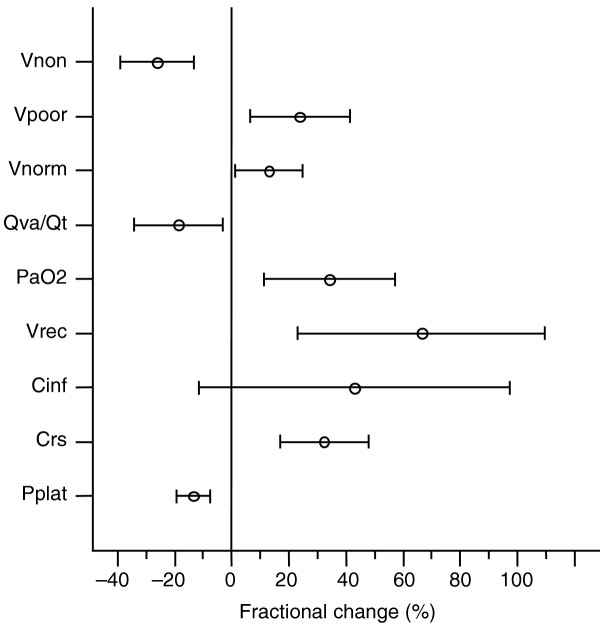
Fractional changes in investigated parameters (means with confidence intervals). Cinf, maximum inflation compliance; Crs, static compliance of respiratory system; PaO2, arterial partial oxygen pressure; Pplat, plateau pressure; QVA/QT, venous admixture; VNON, nonaerated lung volume; VNORM, normally aerated lung volume; VPOOR, poorly aerated lung volume; Vrec, recruitable volume at PEEP.